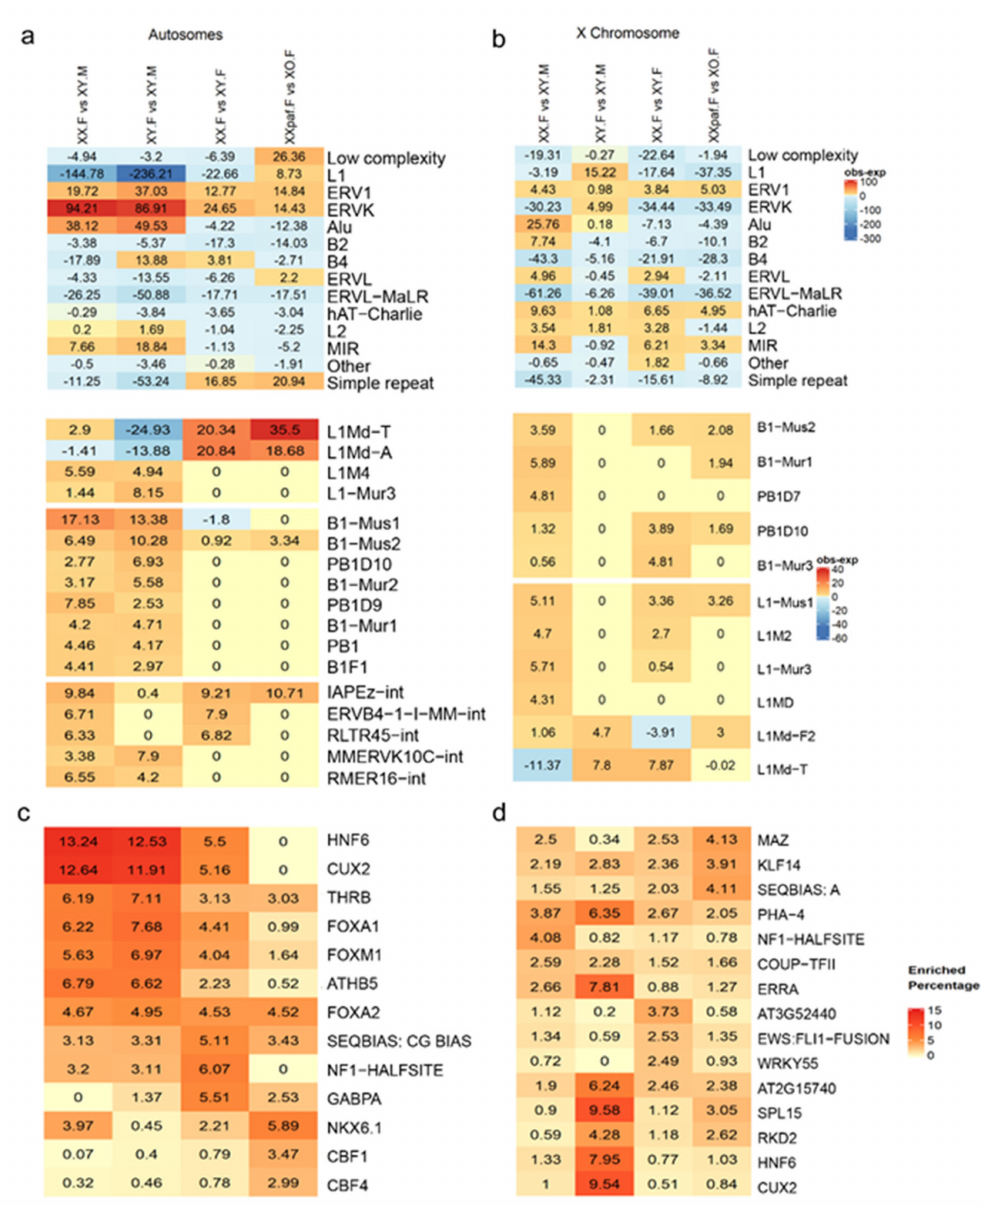
Figure 4. Enrichments of repeat families and transcription factor binding motifs at sDMRs di ff er between autosomes and the X chromosome. ( a , b ) Enrichment of repeats at family and subfamily levels. Each row represents one repeat family / subfamily and the color intensity represents the increased frequency of repeat family / subfamily overlapped with sDMRs (obs) compared with background (exp), the average of 1000 randomly generated sets of 300 bp regions. ( a ) Enrichment of repeats for autosomal sDMR at family (top) and subfamily (bottom) levels. The three selected repeat families from the top to bottom split portions are L1, Alu, and endogenous retrovirus K (ERVK). ( b ) Enrichment of X-linked sDMR with repeats at family (top) and subfamily (bottom) levels, where the two selected repeat families are Alu and L1. ( c , d ) Motif enrichment analysis of sDMRs on autosomes ( c ) and on the X chromosome ( d ) using HOMER. The color intensity represents the di ff erence in percentages of sequences with the motif between sDMR and the randomly generated background. The top five motifs from each of the four comparisons are presented and clustered based on the Euclidean distance between the enrichment